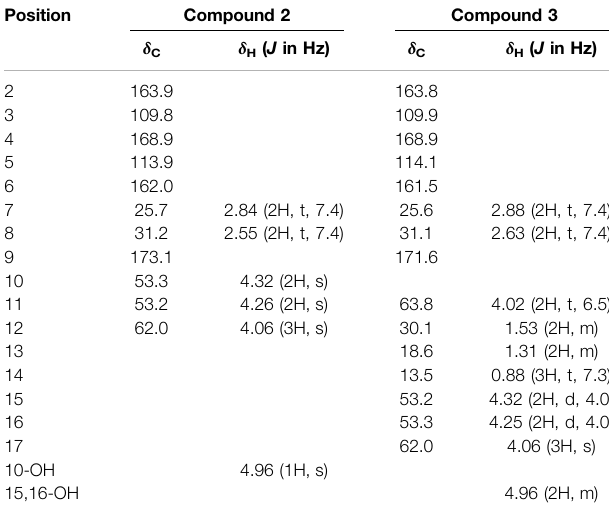
TABLE 2 | 1 H NMR and 13 C NMR spectral data in DMSO- d 6 for compounds 2 –